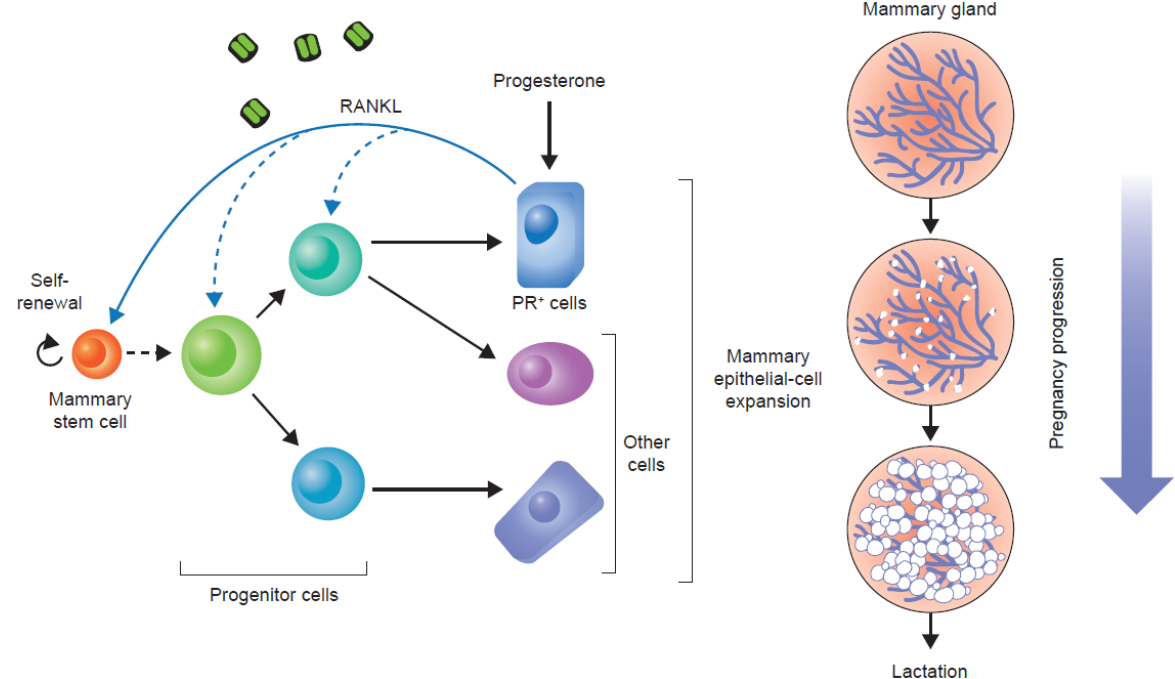
Figure 2. RANKL in mammary gland epithelial cell proliferation. Following the binding of progesterone to its receptor, RANKL is produced and acts in a paracrine fashion to stimulate mammary gland epithelial cell expansion. PR, progesterone receptor. Reprinted from